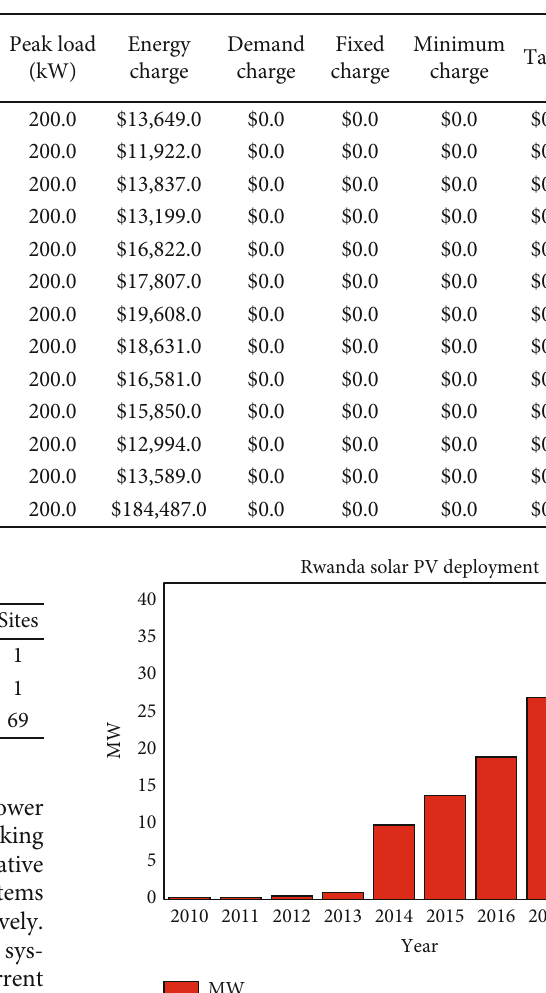
Table 22: Utility monthly summary — proposed system (South Sudan).